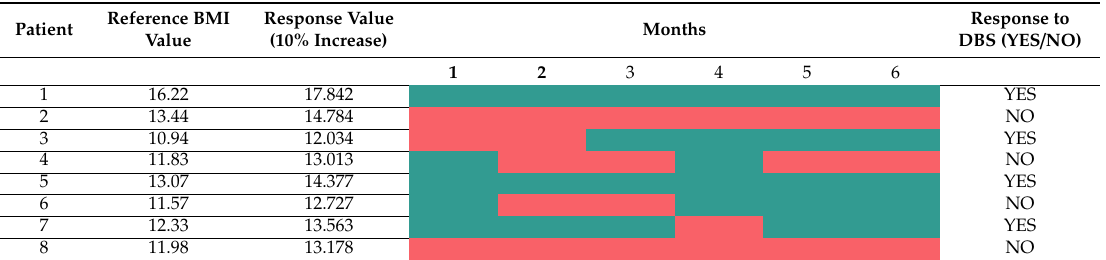
Table 2. Participant response defined as a 10% increase in BMI during the six-month follow-up period. Reference BMI Response Value Patient Value (10%